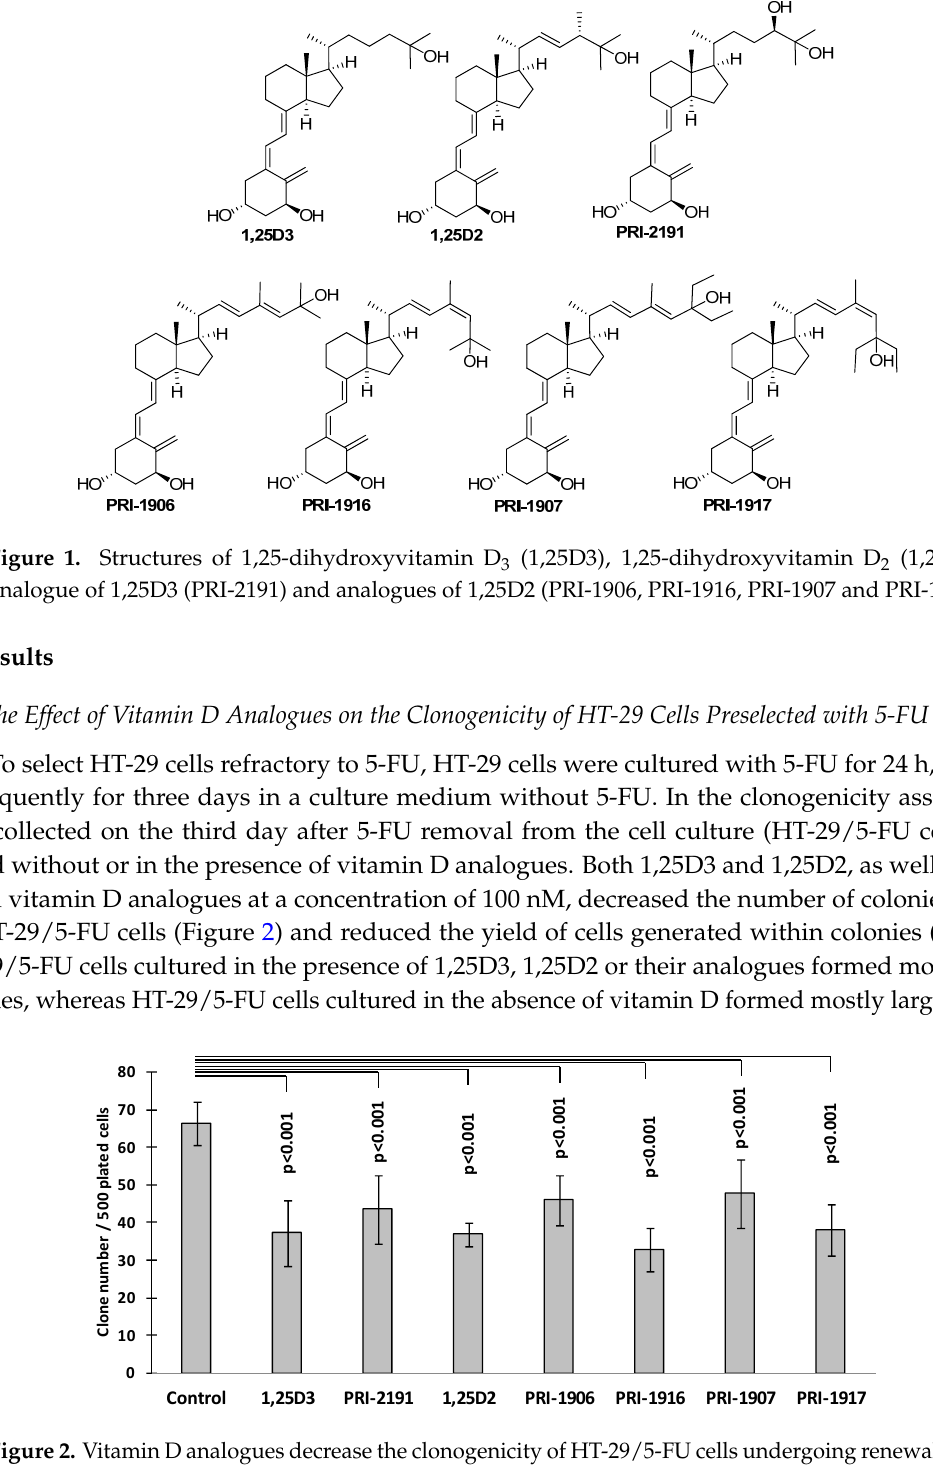
Figure 2. Vitamin D analogues decrease the clonogenicity of HT-29/5-FU cells undergoing renewal. The bar graph represents a mean colony numbers ± standard deviation in control cultures and in cultures with 1,25-dihydroxyvitamin D3 (1,25D3), analogue of 1,25D3 (PRI-2191) 1,25-dihydroxyvitamin D2 (1,25D2), and analogues of 1,25D2 (PRI-1906, PRI-1916, PRI-1907 and PRI-1917). HT-29/5-FU cells were collected on the third day after the exposure to 5-FU and were plated in the clonogenicity assay in n = 6 replicates. Statistically significant differences between mean colony-forming cell number in control cultures and cultures with vitamin D analogues were determined by Dunnett’s test. Data from one of two experiments with similar results are